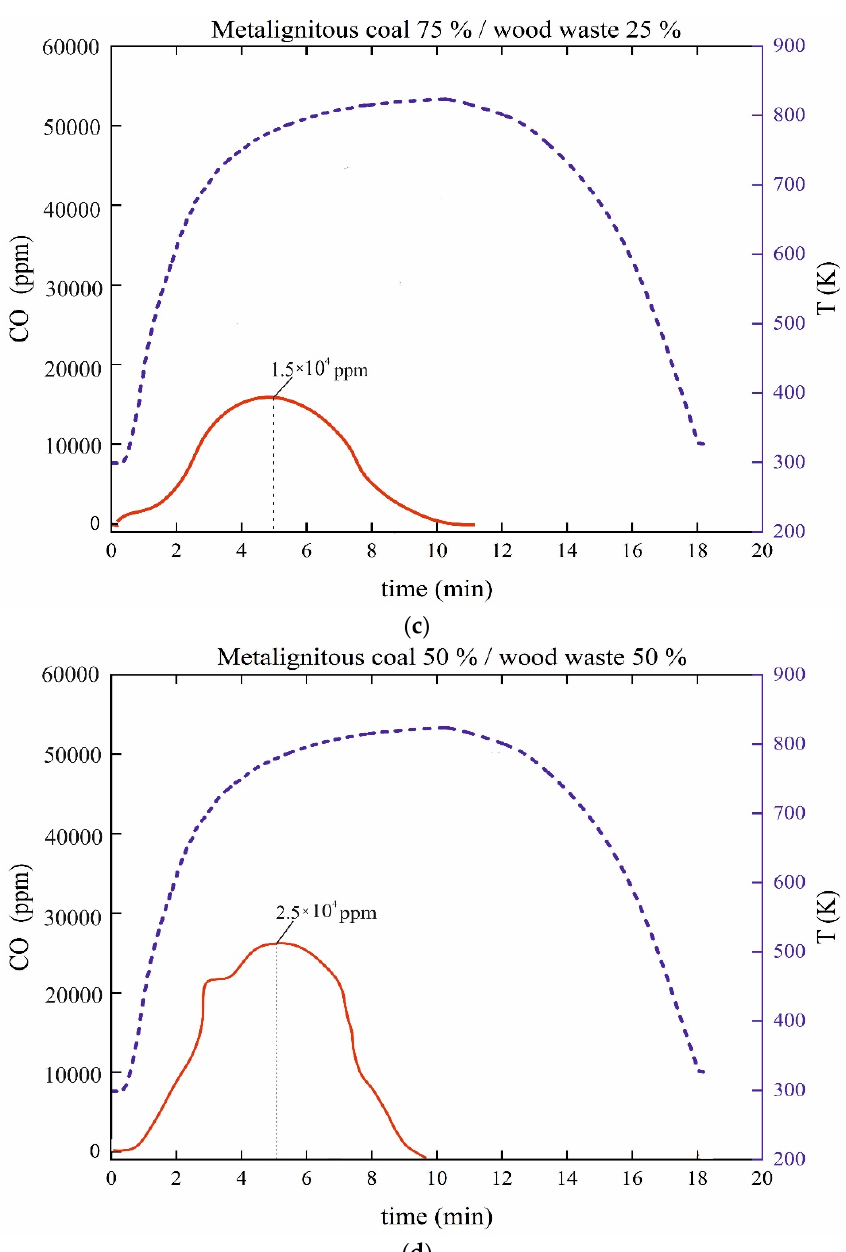
Figure 5. Changes in the concentration of carbon oxide in the gaseous products of thermal decomposition of mixed fuels based on D-grade coal and wood with a change in the proportion of the latter in the mixture from 10% to 50%: ( a ) metalignitous coal 100%; ( b ) metalignitous coal 90%/wood waste 10%; ( c ) metalignitous coal 75%/wood waste 25%; ( d ) metalignitous coal 50%/wood waste 50%. Table 2. The results of calculating the areas under the gas curves for metalignitous coal.